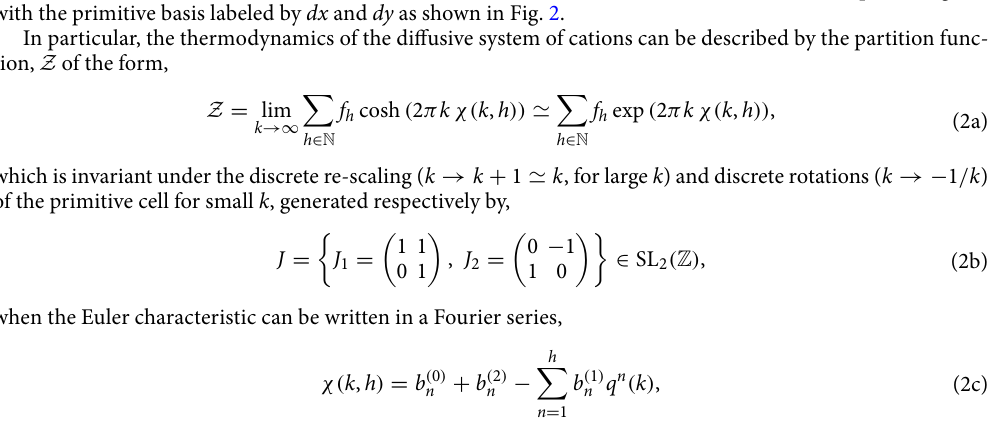
Figure 2. Unit (primitive) cell ( dx / dy with lattice constant, a showing the primitive vectors, dx and dy . Every primitive cell is a parallelogram engulfing two (un-)occupied cationic sites, spanning partial interiors of four cationic-site